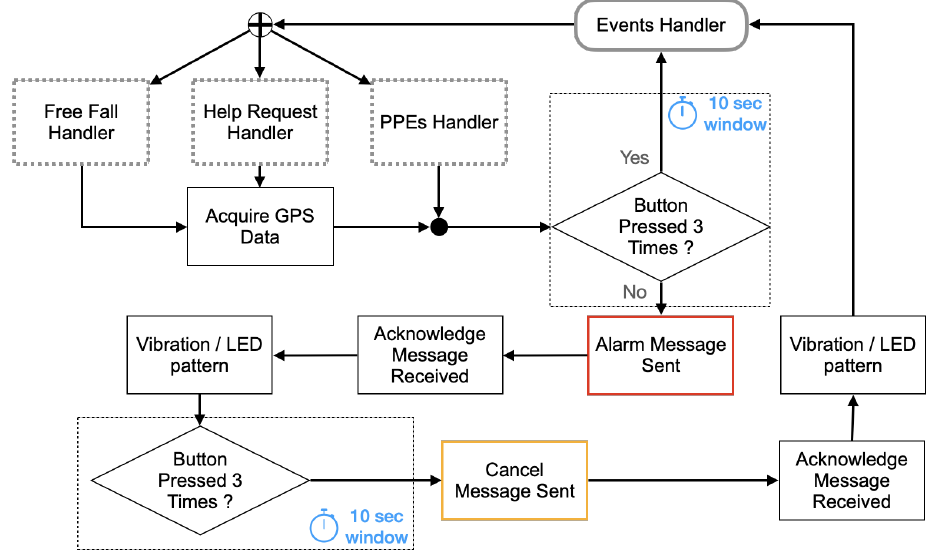
Figure 14. False alarm cancellation